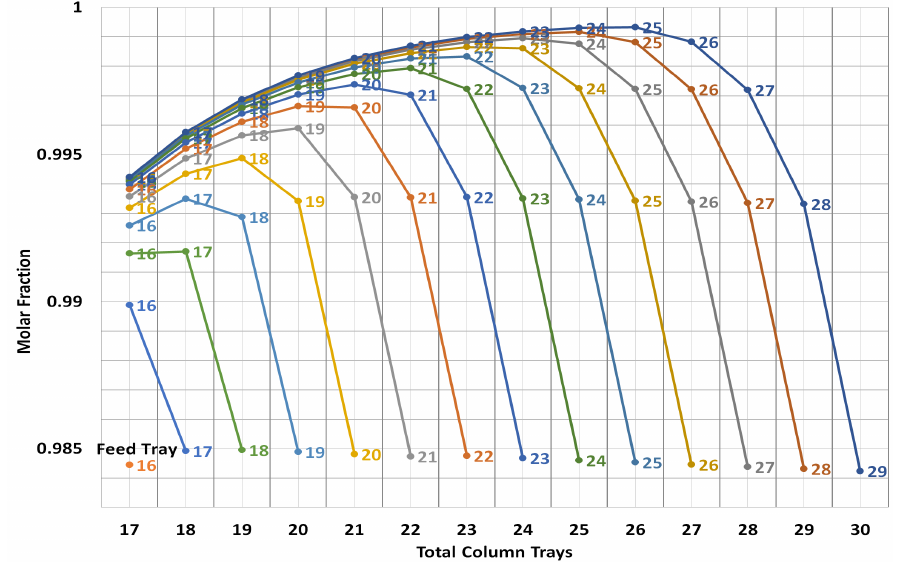
Figure 4. Influence of the feed tray location ( x -axis) on the ethanol purity ( y -axis), for different numbers of stages (from 17 to 30, numbers varying over the curves). Case with reflux ratio equal to 6.42.